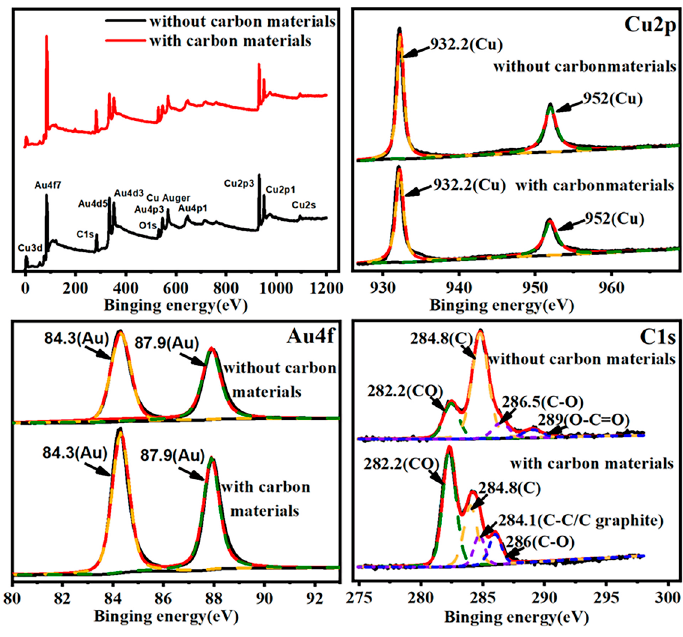
Figure 3. XPS for full survey spectra, Cu 2p, Au 4f and C 1s.